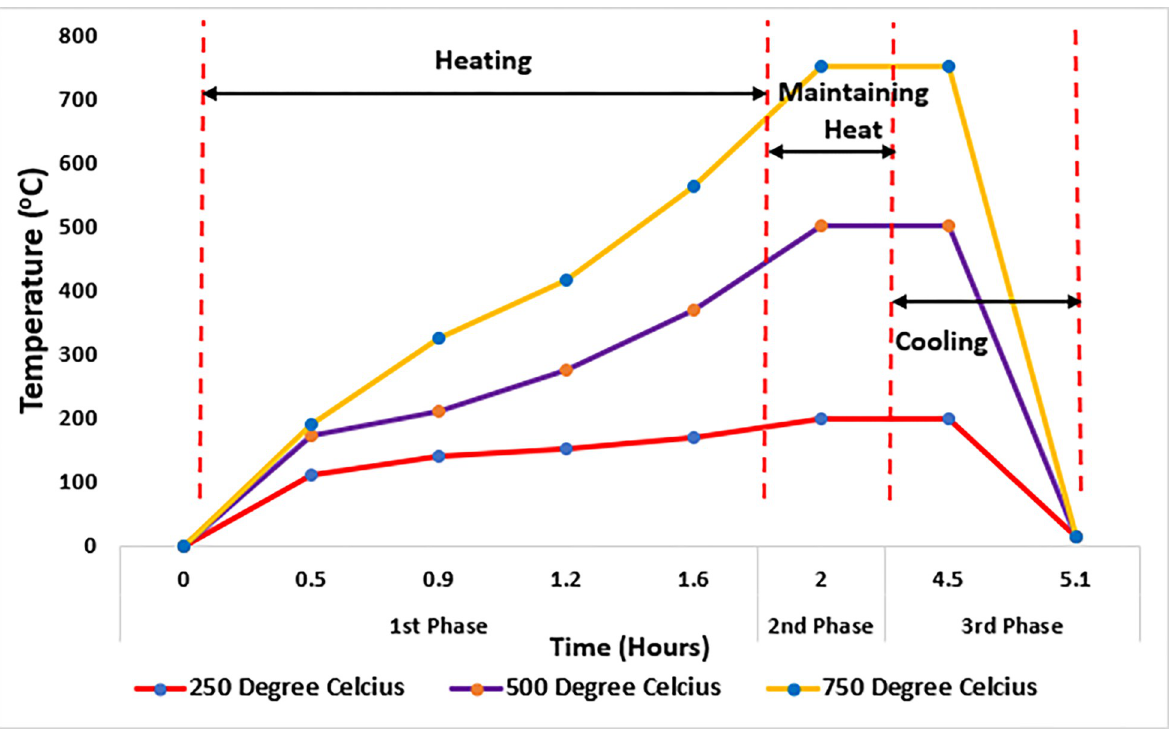
Fig 8. Heating and Cooling regime of elevated